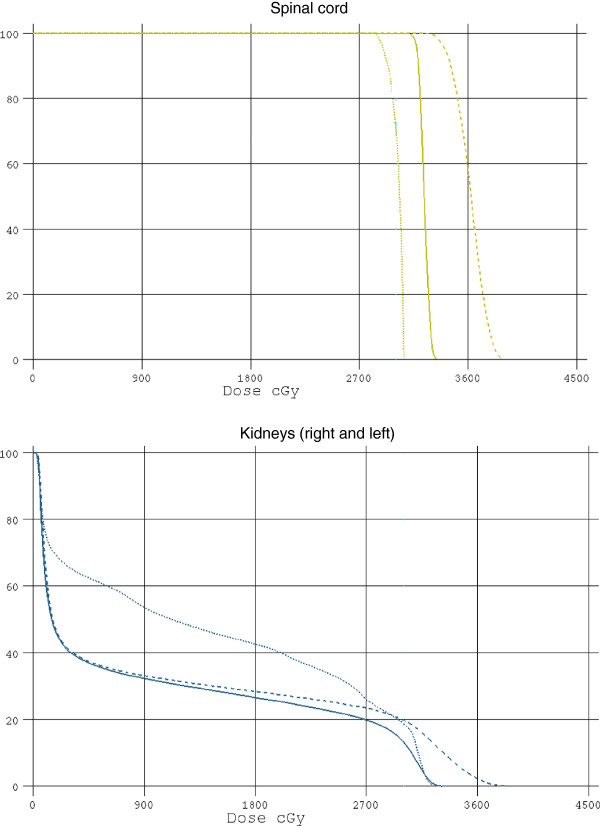
Dose volume histogram of the spinal cord and kidneys. It is evident that the 3D plan offers improvement in maximal dose deposited to the spinal cord while maintaining the kidney dose within tolerable limits.